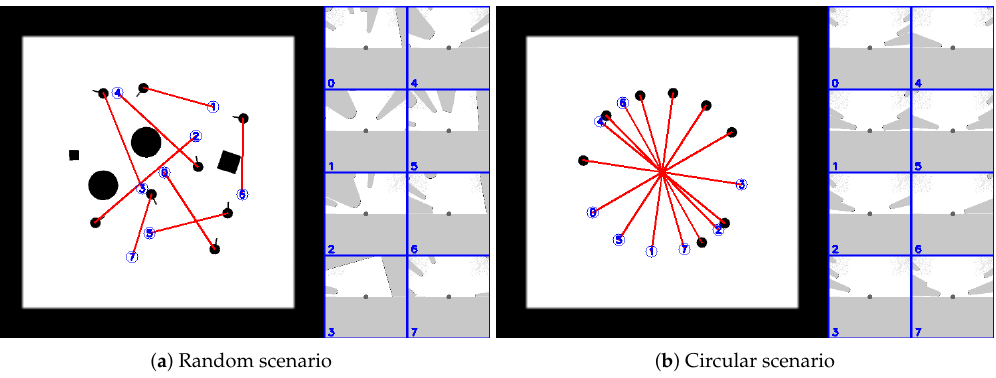
Figure 3. Two scenarios used to collect collision avoidance experiences for multiple robots, where the blue digital circles represent the target goals of the robot with the corresponding number, red lines specify the straight paths from the current position to the target for robots and other black pixels represent various obstacles. Blue boxes on the right illustrate egocentric local grid maps of each